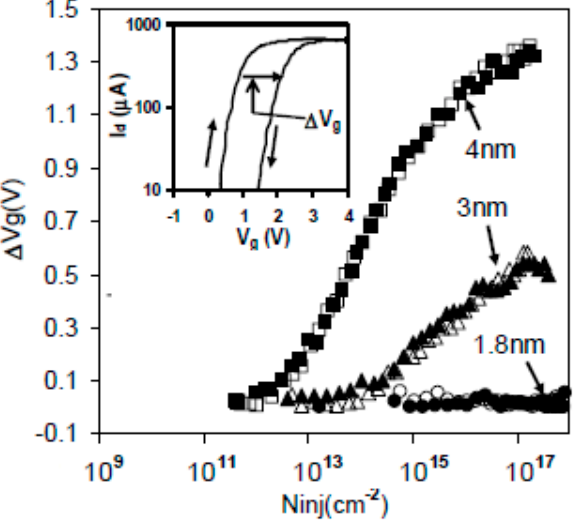
Figure 40. The rapid reduction of as-grown electron trapping with the downscaling of the thickness of HfO 2 [63].